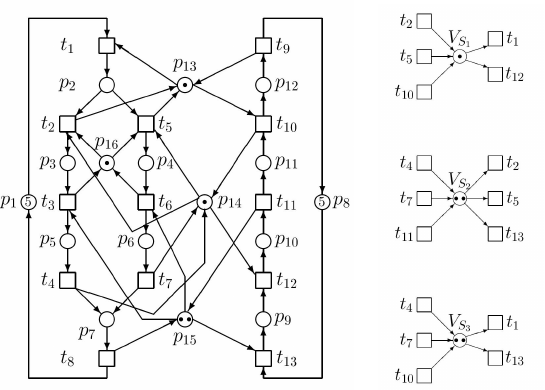
Figure 6. The PN model ( left ) with its supervisor ( right ) created by three monitors and their inter- connections with the uncontrolled